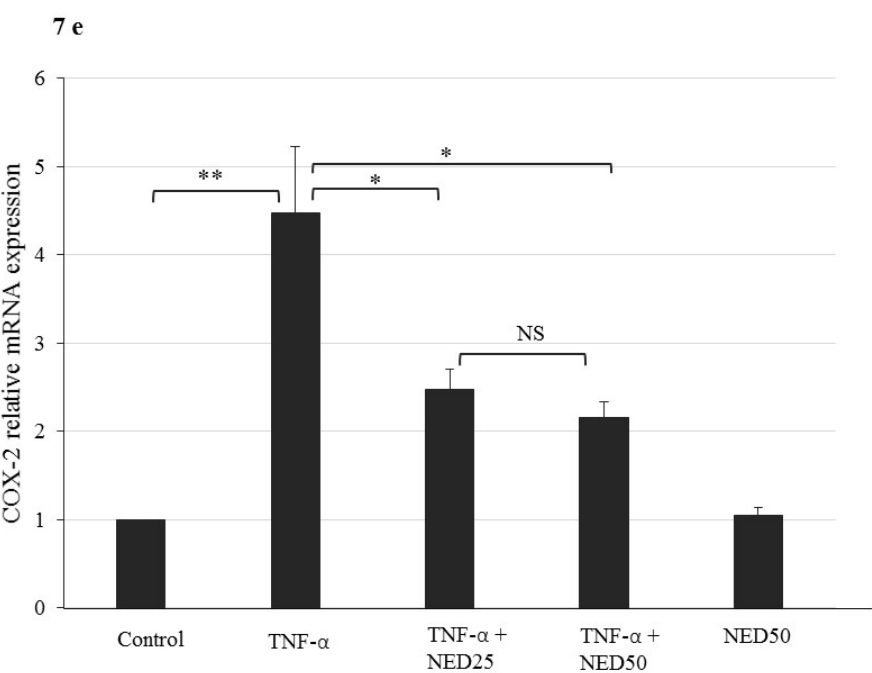
Figure 7. E ff ect of NED on cell viability and proinflammatory cytokine mRNA expression in TNF- α -treated HT-29 human colonic cancer cells. The concentration-dependent cytotoxic e ff ects of NED were investigated treatment of HT-29 cells with di ff erent concentrations of NED for 24 h. NED had no e ff ect on HT-29 cell viability at concentrations up to 100 µ M, so its anti-inflammatory e ff ects were examined at concentrations of 25 and 50 µ M in the subsequent experiments ( a ). To investigate the e ff ect of NED on inflammatory cytokine production, cells were treated with 1 ng / mL TNF- α for 24 h. Real-time PCR was carried out to detect gene expression of the inflammatory markers CXCl1, CXCL2, IL-8, and COX-2 ( b – e ). Data are shown relative to DMSO vehicle-treated cells. Data expressed as mean ± SEM ( n = 6). *** p ≤ 0.001. ** p ≤ 0.01. * p ≤ 0.05. p values were obtained by one-way ANOVA followed by Tukey’s multiple comparison test using SPSS software. p ≤ 0.05 was considered statistically significant, and NS indicates not significant.